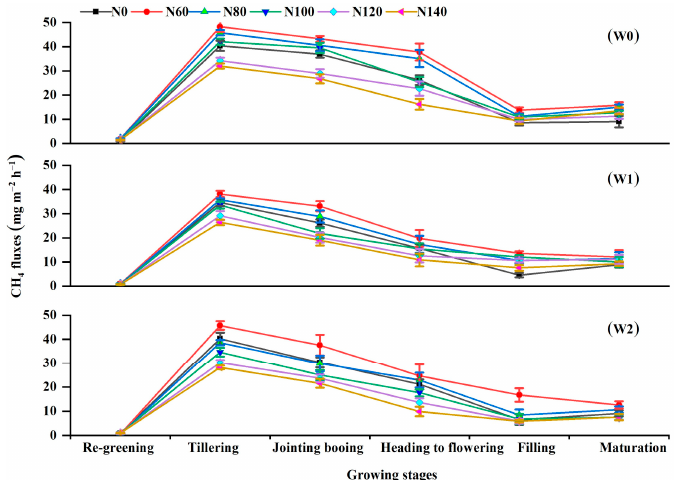
Figure 3. Variations in CH 4 fluxes as affected by irrigation regimes with different N application rates during the rice-growing period. W0, W1, and W2 represent continuous flooding, intermittent irrigation, and control irrigation, respectively. Urea application at rates of 0 (N0), 60 (N60), 80 (N80), 100 (N100), 120 (N120), and 140 (N140) kg N ha − 1 Overall, N 2 O emission patterns were relatively low compared with CH 4 emission patterns during the rice-growing seasons (Figure 4). Application of N fertilization at the tillering stage caused a sharp increase in flux in all treatments, which peaked at the joint- ing–booting stages. Except for a few small peaks at the maturation stage, the fluxes then gradually declined and remained elevated (Figure 4). Among the six N fertilization levels, the peaks were in the order of N120 > N140 > N100 > N80 > N60 > N0, except for N80 = N60 under W0. Furthermore, the peak N 2 O fluxes differed significantly among different water regimes. Compared with W0 irrigation, W1 and W2 produced peak N 2 O emissions that were on average 99.0% and 44.1% higher than that of the W0 irrigation after the sec- ond dressing, respectively. Among the different treatments, the highest N 2 O fluxes were observed under the W1N120 treatment, while the lowest N 2 O fluxes occurred under the W0N0 treatment.